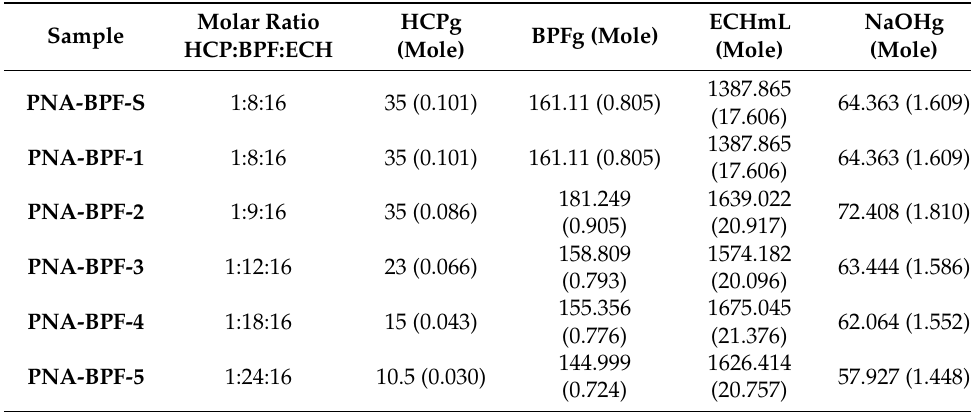
Table 1. The amounts of initial reagents for the synthesis of